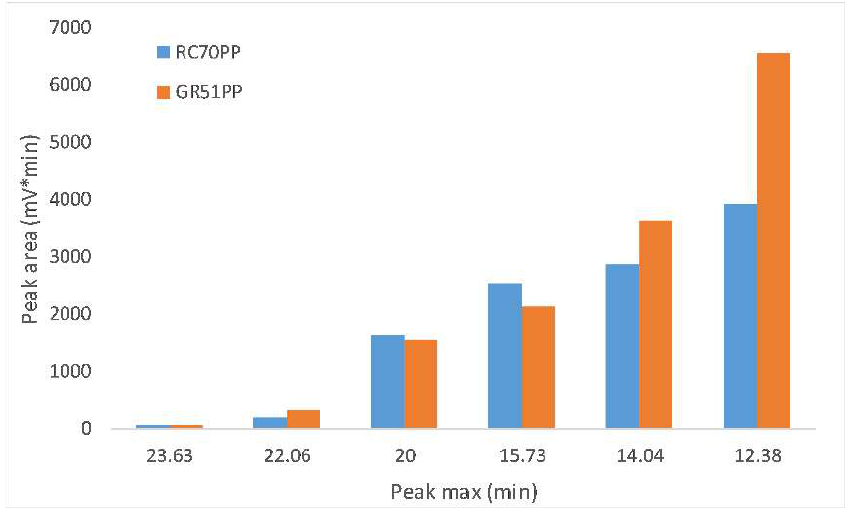
Figure 8. Comparison of the size-exclusion chromatography peak areas (RI) for the results shown in Figure 7 (RC70PP and GR51PP membranes).